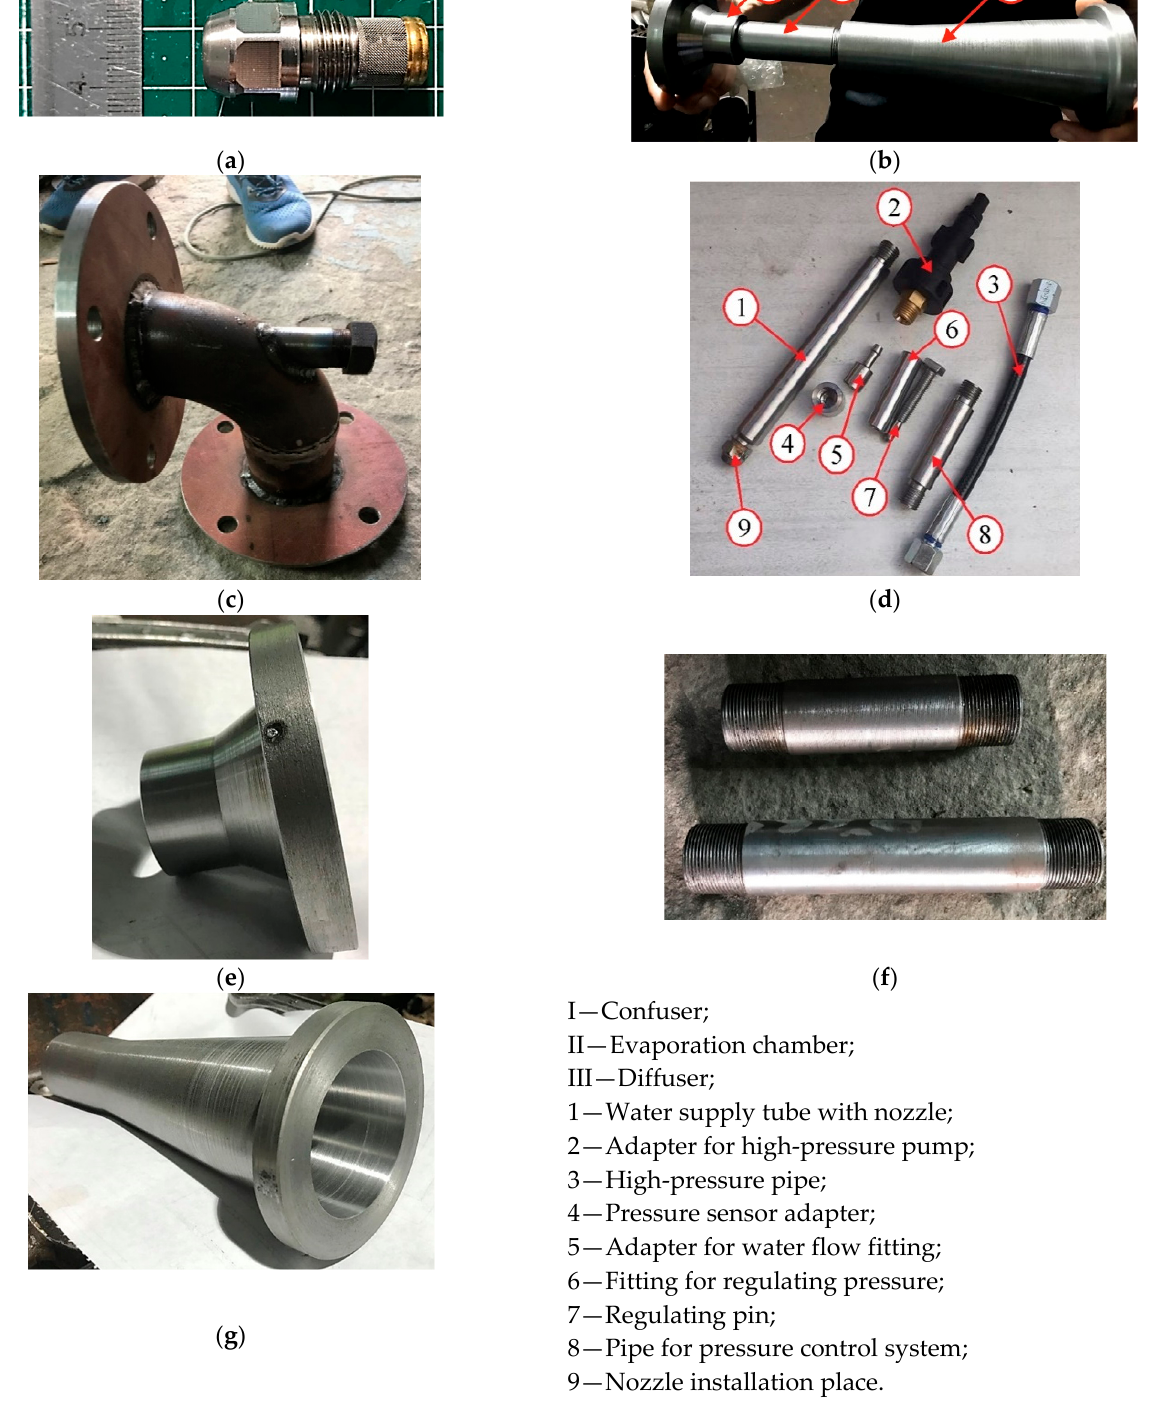
Figure 3. Experimental thermopressor: nozzle for liquid injection system ( a ); main elements of the thermopressor ( b ); receiving chamber ( c ); liquid injection system ( d ); confuser ( e ); evaporation chamber ( f ); diffuser ( g ).